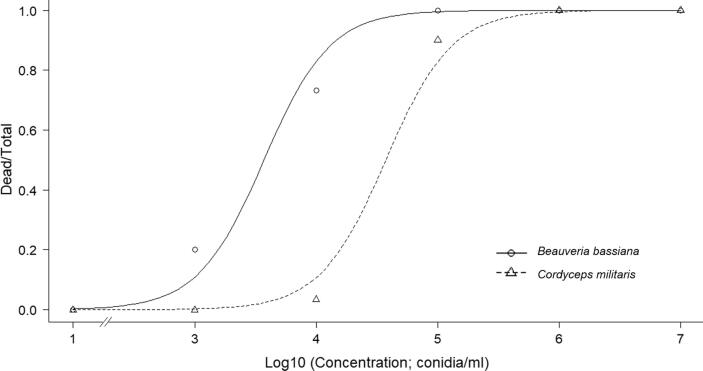
Proportion mortality of G. mellonella larvae following treatment with EPF. Mean proportional mortality of G. mellonella larvae (N = 30 for each dose) injected with B. bassiana and C. militaris conidia at six concentrations on day 6 after treatment. A two-parameter log-logistic model is fitted to the responses.